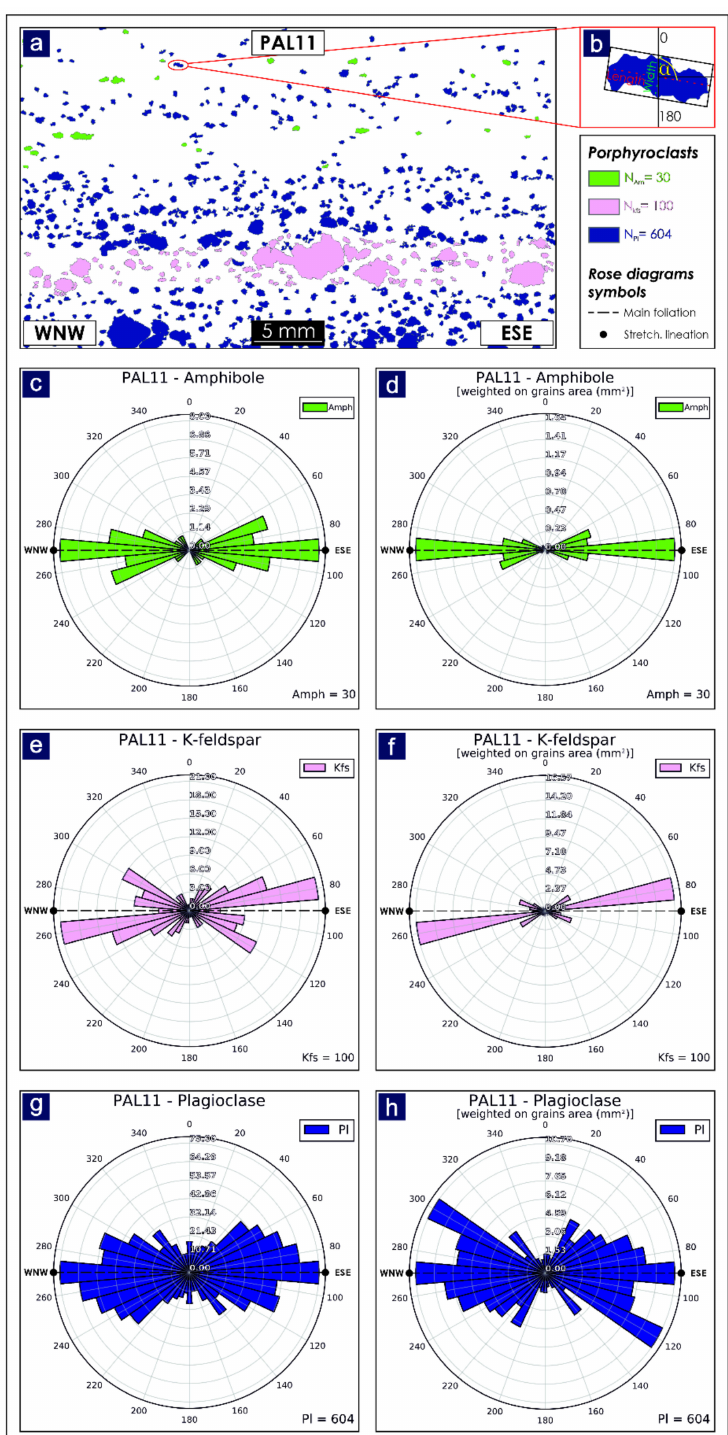
Figure 17. Application of ‘Rose Diagrams’ tool to PAL11 microstructural data. ( a ) Porphyroclast grain boundary detection map obtained via Min-GSD routine [4]; ( b ) scheme of the minimum bounding geometry data extraction for each single clast, where α represents the angle between the normal to the main foliation in thin section with the major axis of the bounding box; ( c , e , g ) unweighted rose diagrams; ( d , f , h ) weighted rose diagrams based on grains cumulative area (in mm 2